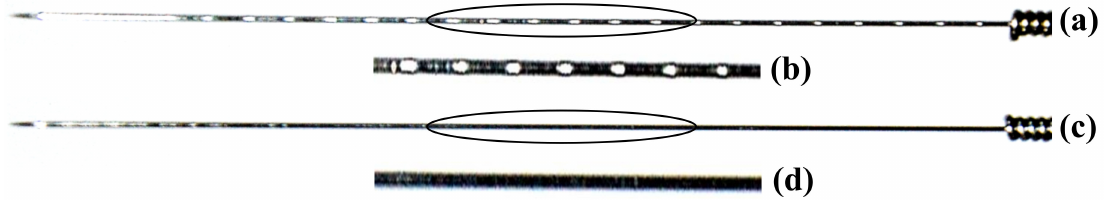
Figure 1. Comparison of acupuncture needles: ( a ) Nano-SS needle, ( b ) a higher magnification image taken from the black circle in ( a ) showing the laser-modified surface feature, ( c ) U-SS needle, and ( d ) a higher magnification image taken from the black circle in ( c ) showing the surface without any modification